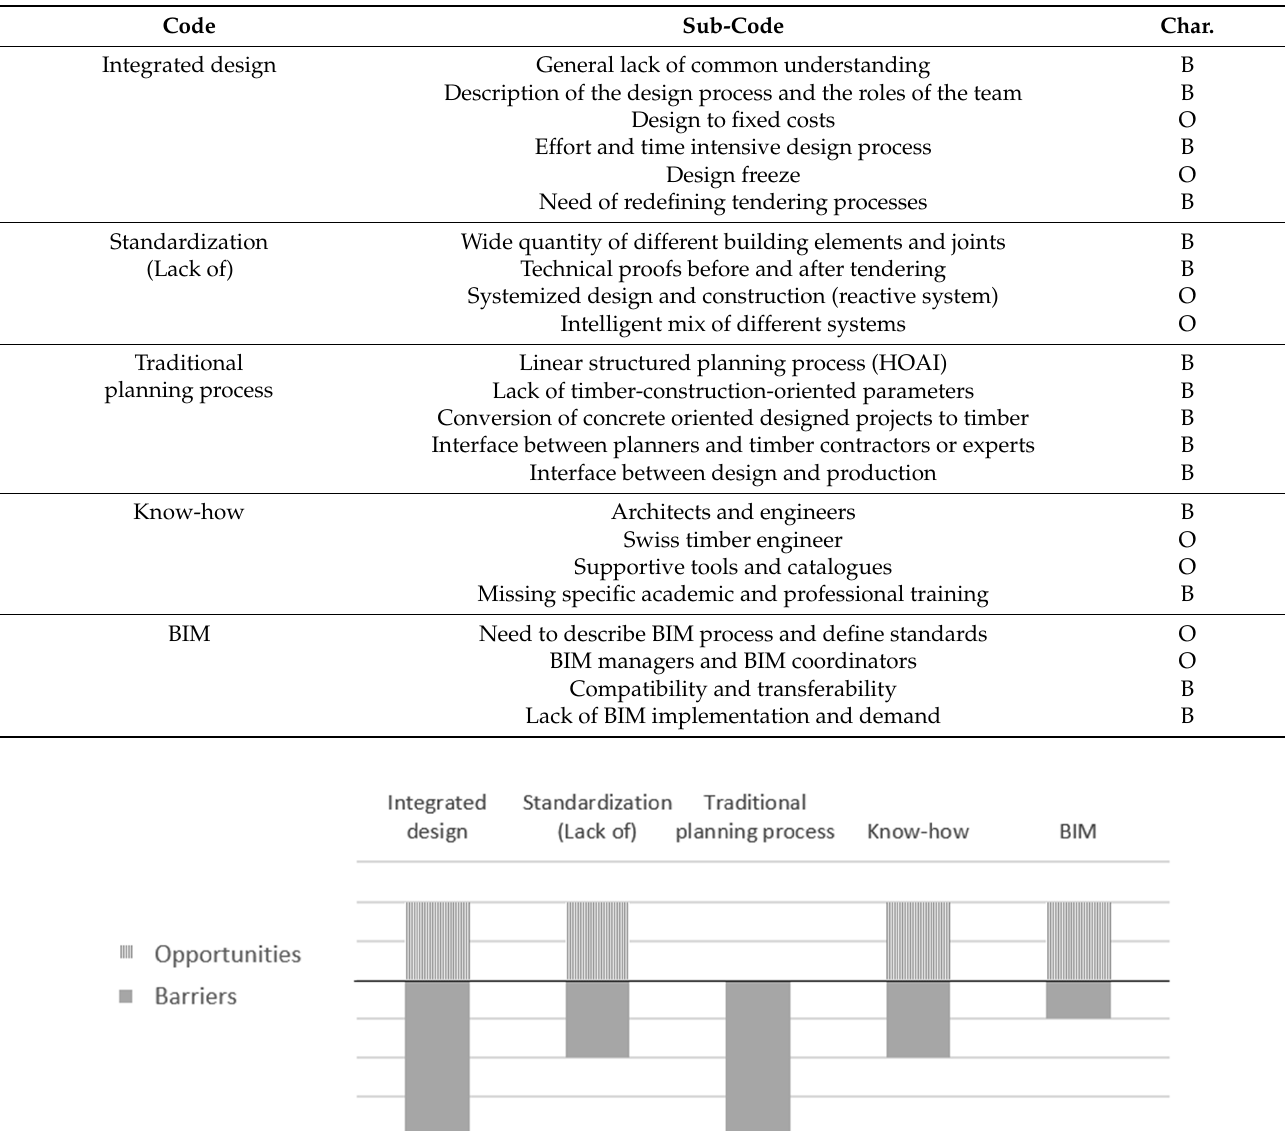
Table 5. Summary of codes in category Design with their embedded sub-codes and character ac- cording to their frequency of nomination.